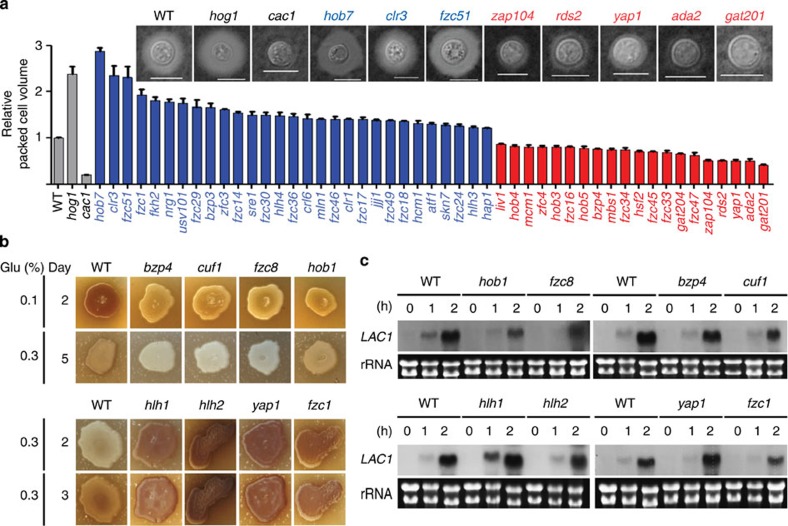
TFs involved in virulence-factor production in C. neoformans.(a) TFs involved in capsule production. WT strain H99 and TF mutants were spotted onto a Dulbecco's Modified Eagle's (DME) agar medium and incubated at 37 °C for 2 days. Scraped cells were resuspended in distilled water and visualized by means of India ink staining (see inserted pictures in the graph; scale bars, 10 μm). Each graph indicates average relative packed cell volume of two independent TF mutants that exhibited statistically significant changes in capsule production (P<0.05) as shown in Supplementary Fig. 4. Triplicate technical experiments with two or more independent strains were performed. Statistical difference in relative packed cell volume was determined by one-way analysis of variance with Bonferroni's multiple-comparison test. Error bars indicate s.e.m. The hog1Δ and cac1Δ mutants were used as capsule-enhanced and capsule-defective control strains, respectively. (b,c) TFs involved in melanin production. (b) Indicated TF strains were spotted and grown on Niger seed agar medium (with 0.1 and 0.3% glucose) at 37 °C. The plates were photographed daily. (c) Northern blot analyses were performed using total RNA isolated from cells under glucose-rich (0 h) and -depleted conditions (1 and 2 h). Each membrane was hybridized with a LAC1-specific probe, washed and developed.